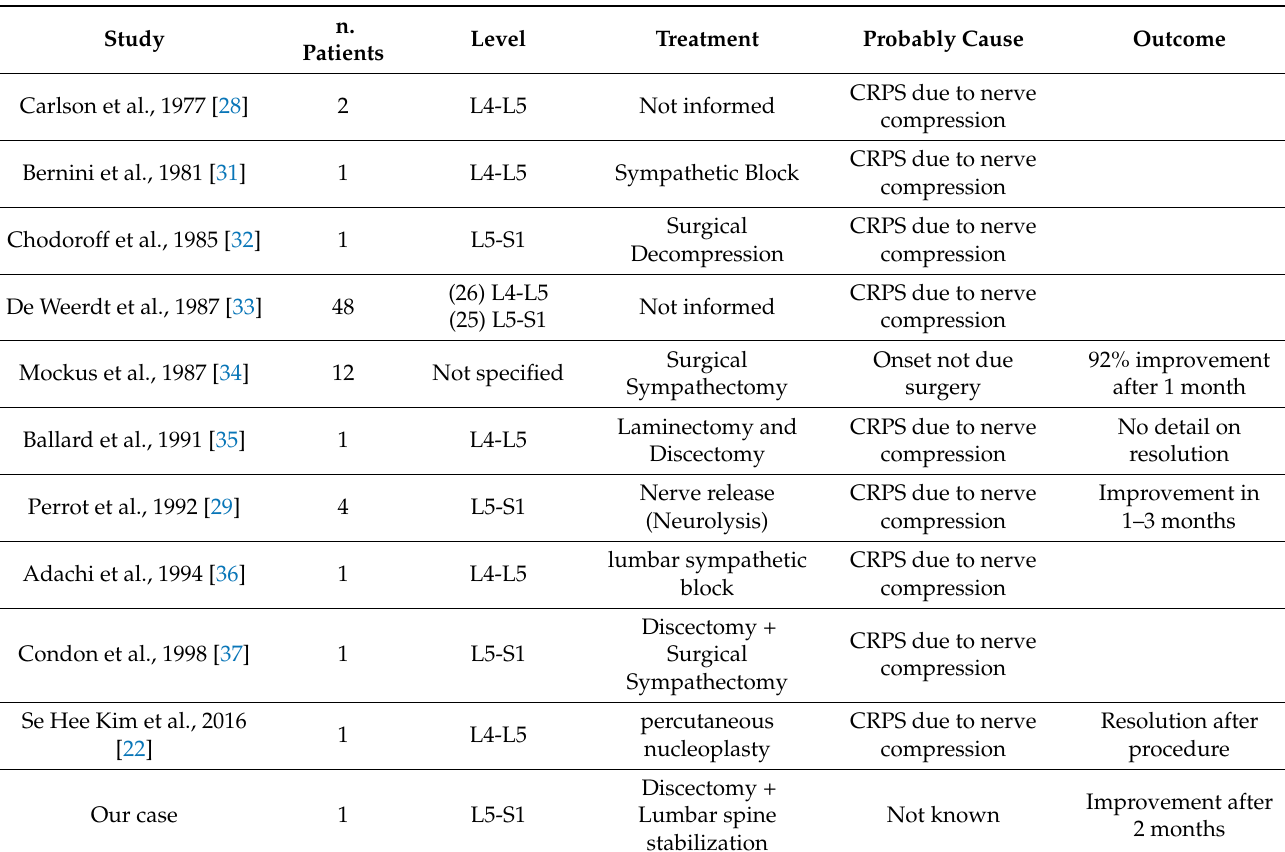
Table 1. Patient’s